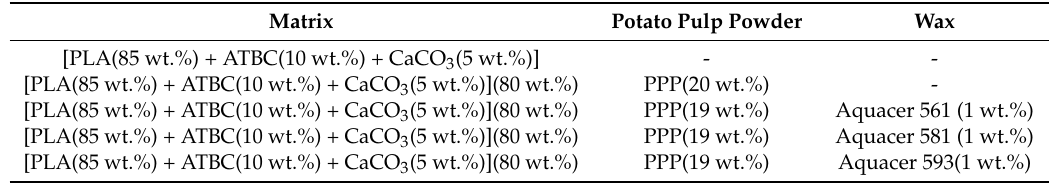
Table 2. Composition of the PLA matrix and